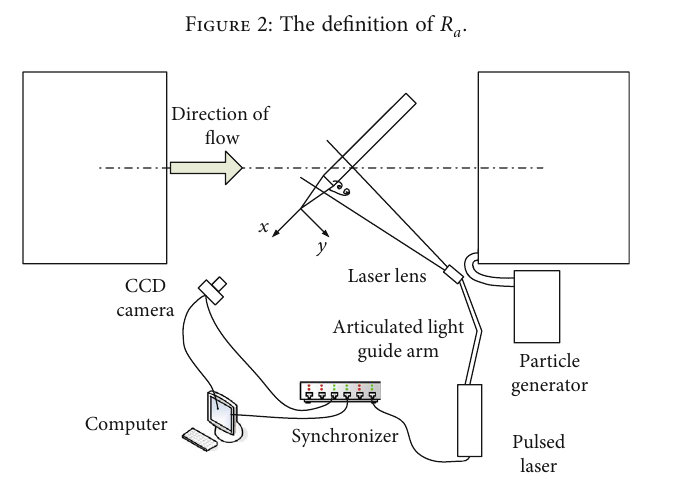
Figure 2: The de fi nition of R